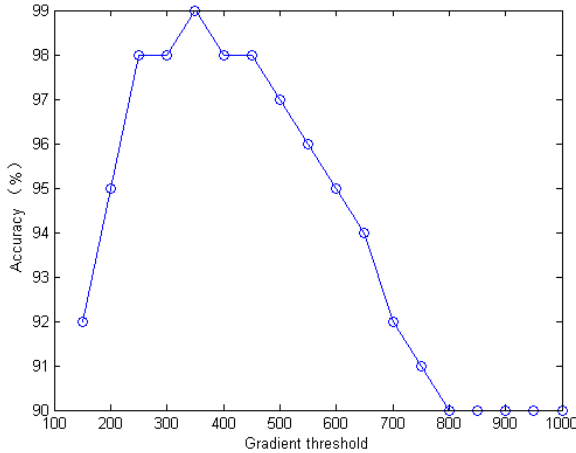
Figure 11. Gradient threshold analysis.